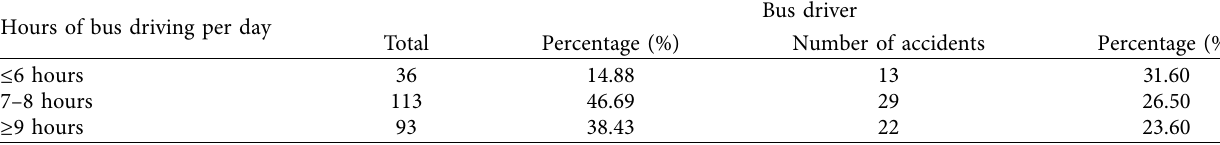
Table 12: Distribution of daily bus time.